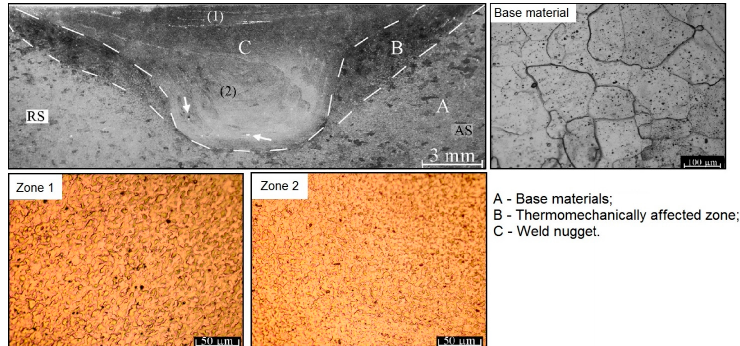
Figure 3. Macro- and microstructure of single-pass FSPed 6063 aluminum alloy (reproduced from [39], with permission from Elsevier, 2019).